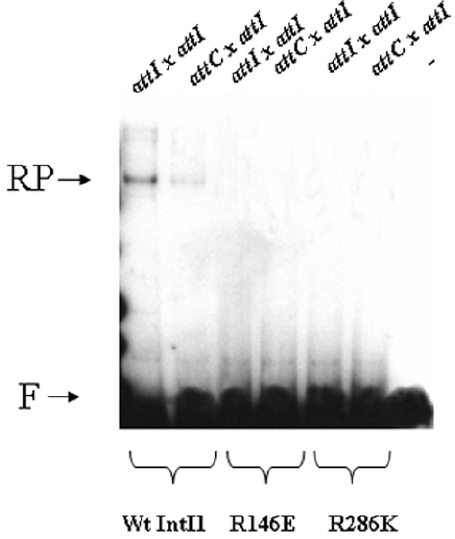
Figure 7. Invitrorecombination catalyzed by wild type, R146E and R286K mutated IntI1. Reactions were performed for 90 min in the presence of purified enzyme (5 pmoles), 0.1 pmoles of linear radiolabeled recombination sites attI1 or attC and 0.1 pmoles of pGEM-T- attI1 under standard conditions described in materials and methods section.Products were loaded on 1% agarose gel and autoradiographied. F: free recombination sites, RP: recombination products.